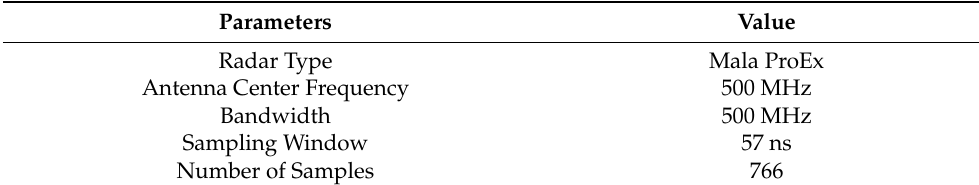
Table 2. Detailed information about the radar parameters.